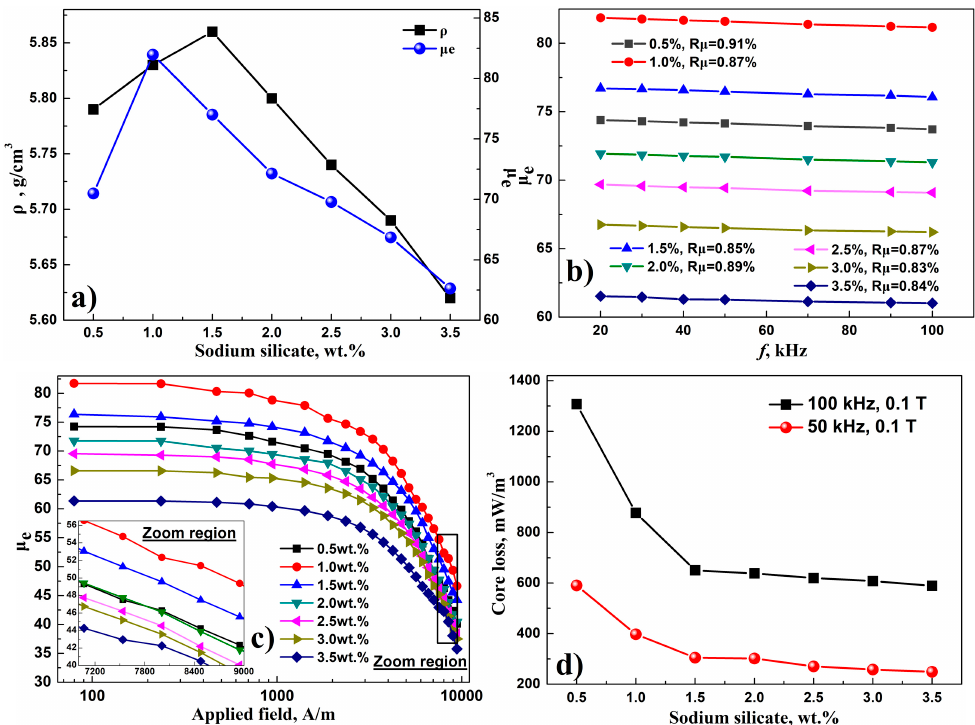
Figure 7. Dependence of the sodium silicate content on the compact density, the effective permeability ( a ), the frequency characteristic ( b ), the DC-bias performance ( c ), and the core loss ( d ) for the AMPCs.